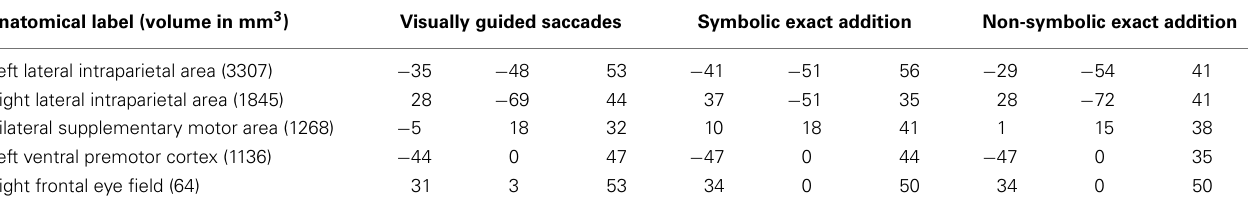
Table 5 |Anatomical labels and volumes in cubic millimeter of clusters significantly only in the visually guided saccades task as well as in the symbolic and the non-symbolic exact addition tasks, but not the visually guided finger movement task and the symbolic and non-symbolic magnitude comparison tasks (depicted in green in Figure 3) with respectiveTalairach coordinates ( x y z ) of peak values for all included